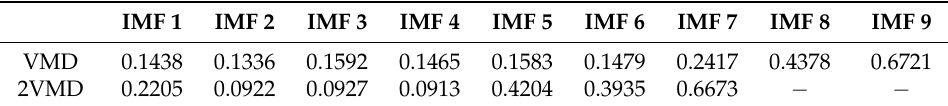
Figure 5. The decomposition result of empirical mode decomposition (EMD), ensemble EMD (EEMD), VMD and 2VMD for the noisy signal. ( a ) EMD; ( b ) EEMD; ( c ) VMD; ( d ) 2VMD. Table 3 . The CCs between the noisy signal and IMFs by VMD and 2VMD.